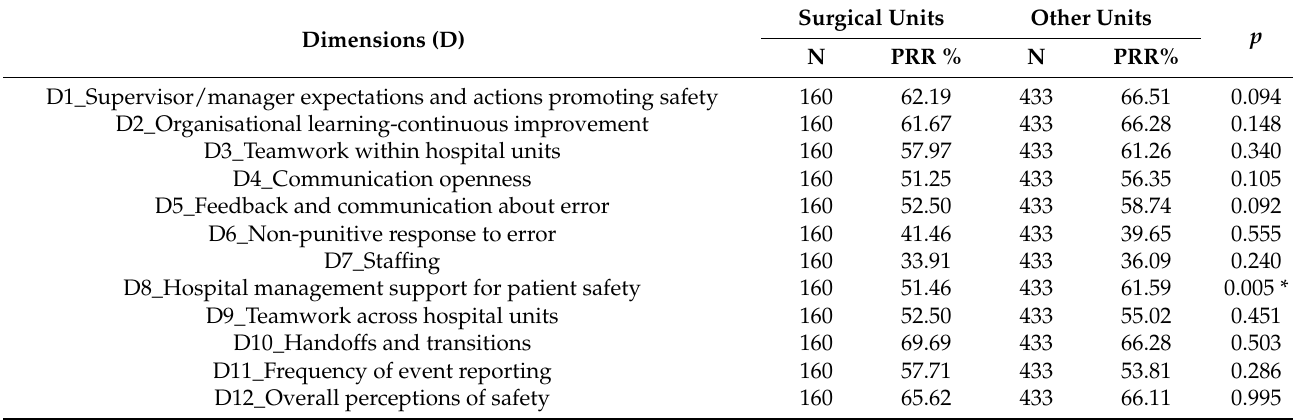
Table 3. Comparison of the PRR regarding “patient safety culture” dimensions of B-HSOPSC among study participants ( n =